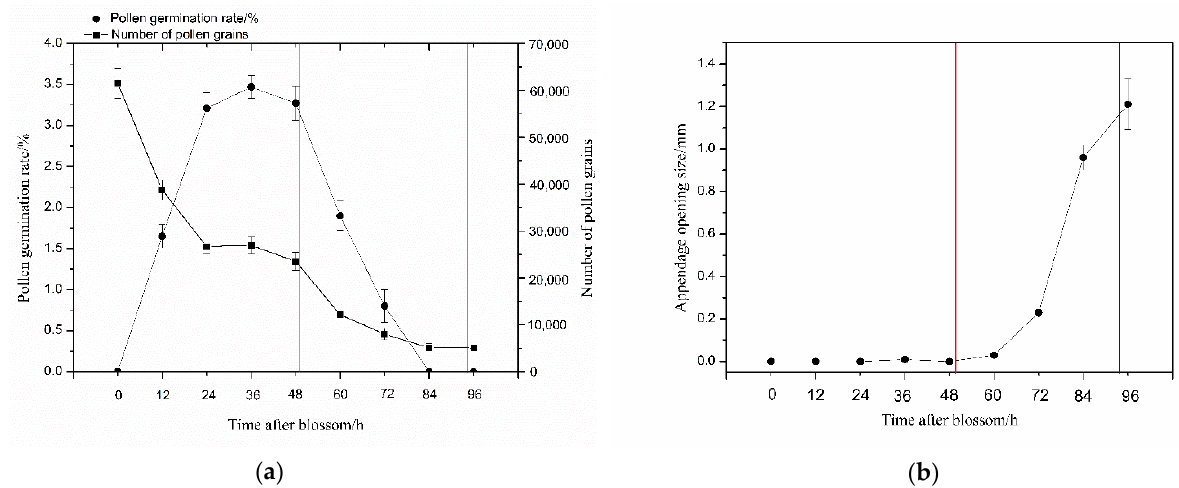
Figure 5. ( a ) The dynamics of the pollen germination rate and number of pollen grains over time after blossom; ( b ) ap- pendage opening size over time after blossom. The red vertical lines refer to time of natural corolla abscission, and the blue vertical lines refer to time of corolla abscission after antirobbing.